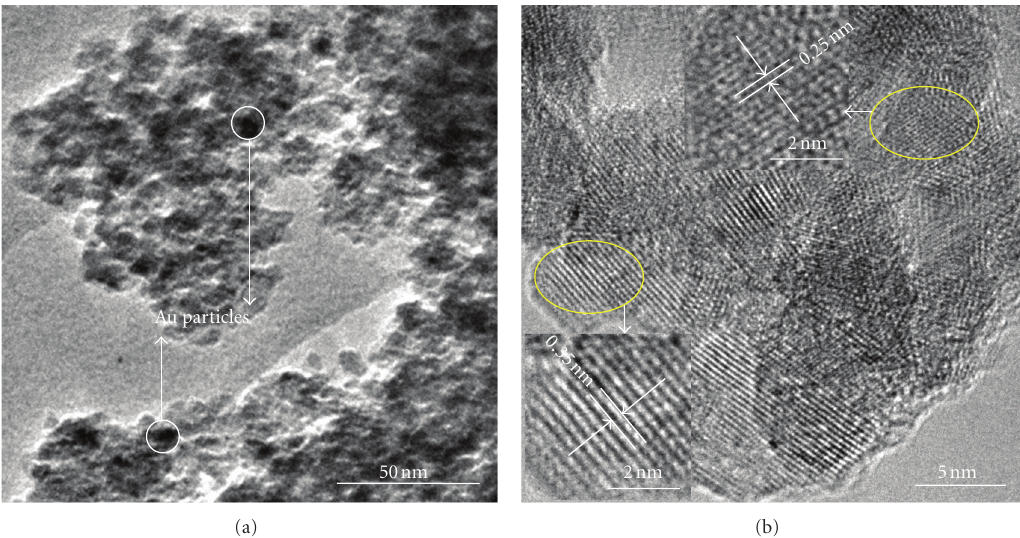
Figure 2: TEM (a) and HRTEM (b) images of the R Au -0.060 composite powder.